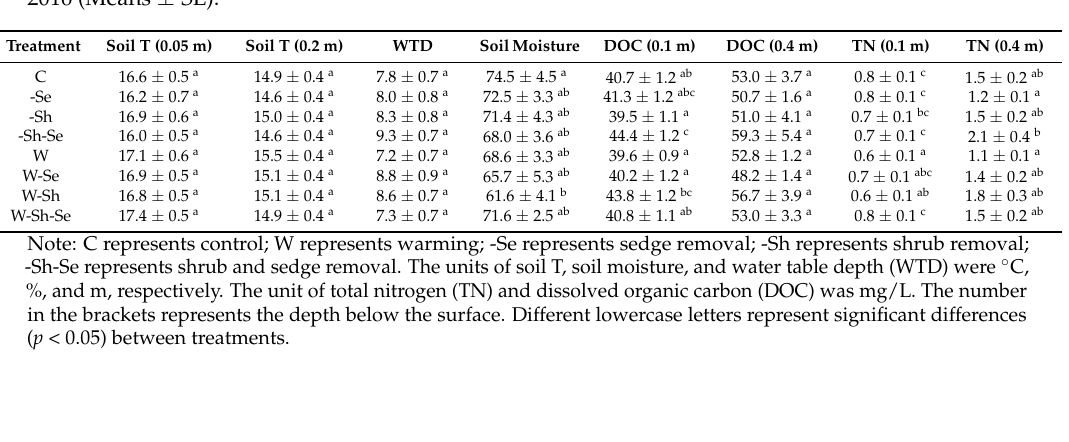
Figure 1. Daytime air temperature in the warming plots (red line) and control plots (black line) during the 2014 growing season. Table 1. Environmental parameters under different treatments during the growing seasons of 2015 and 2016 (Means ± SE).